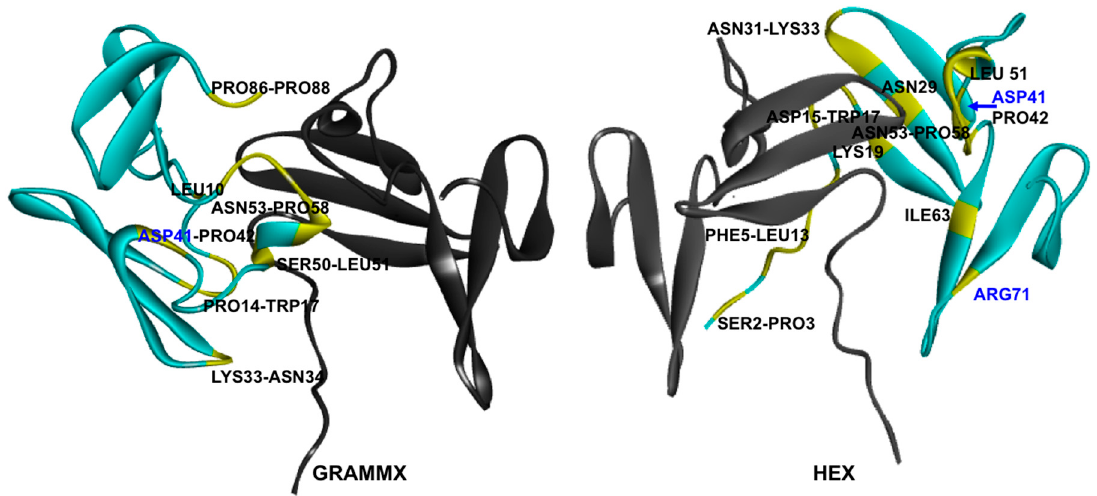
Figure 3. Molecular docking results of two WW34 molecules (green set as ligand and grey set as target) depicting protein–protein interactions that could be responsible for aggregation. The residues found to be less than 4 Å from the structure set as receptor are colored in yellow. GRAMMX, lowest energy solution ( left ); HEX, lowest energy solution ( right ).